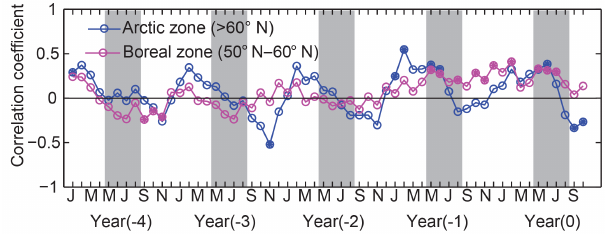
Figure 12. Correlation coefficients for maximum NDVI in a given year (year 0) with lagged 3-month running mean temperature (area- weighted and NPP-weighted). Positive correlations mean greater NDVI during (or following) warmer temperature. Filled circles in- dicate significance greater than the 95% level. Shaded bars indicate the summer months